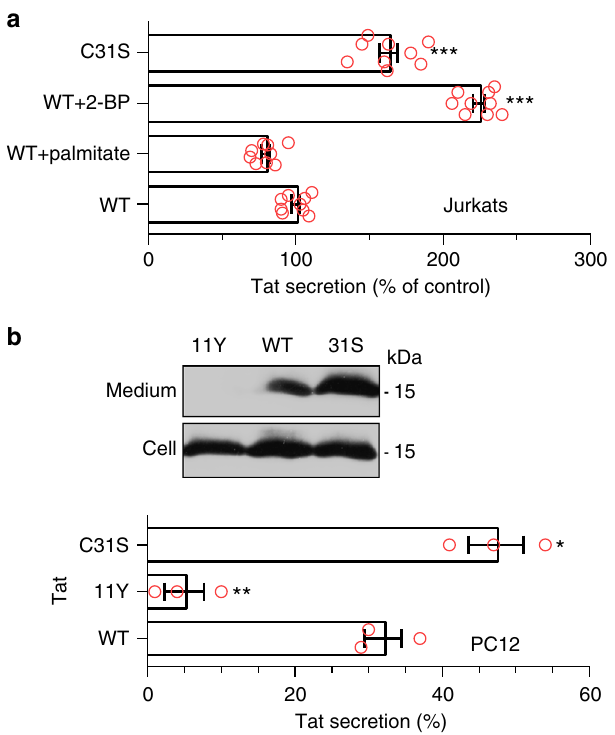
Fig. 5 Tat palmitoylation inhibits its secretion. a Jurkat cells were transfected with Tat or Tat-C31S before treatment for 3 h with 50 µ M 2-BP or palmitate as indicated and assaying Tat secretion by ELISA (Mean ± SEM, n = 3 independent experiments performed in triplicate). b PC12 cells were treated similarly before assaying Tat secretion using immunoprecipitation and Western blotting. Results from a representative experiment are shown together with the quanti fi cation (Mean ± SEM, n = 3). The signi fi cance of differences with controls was assessed using